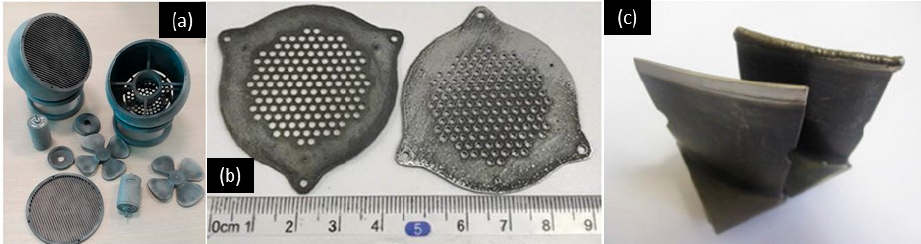
Figure 10. Example of various powder-based 3D-printed mechanical and aerospace application devices ( a ) MJF 3D-printed functional part, feature size 2 mm. Reproduced with permission from [109]; ( b ) SLM 3D-printed ion optics grids. Reproduced with permission from [226]; ( c ) repair of compressor blade by PDMD 3D-prining process, minimum feature size 0.6409 mm to 1.2218 mm. Reproduced with permission from [222].